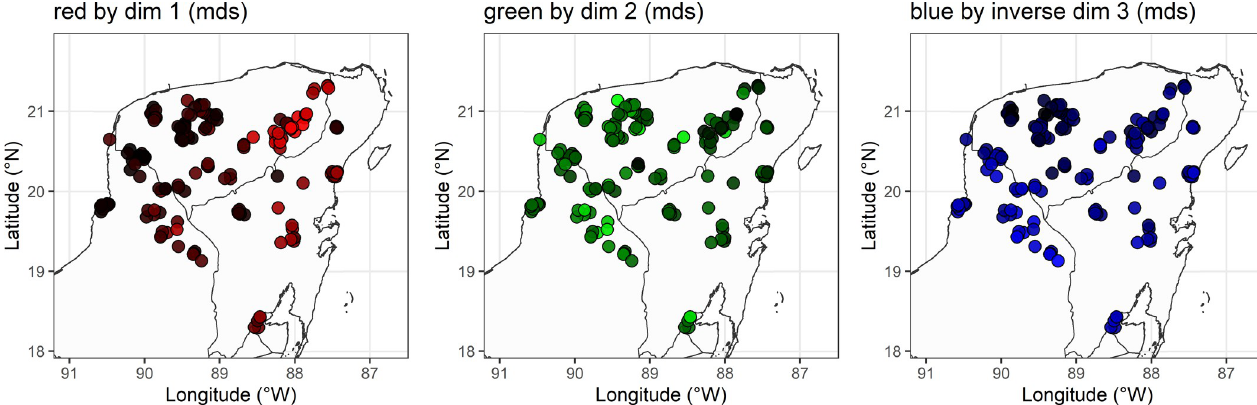
Fig 8. Dimensions of multidimensional scaling. The figures plot the scores of the speakers in the results of multidimensional scaling in color values. (A) red by dimension 1. (B) green by dimension 2. (C) blue by dimension 3.